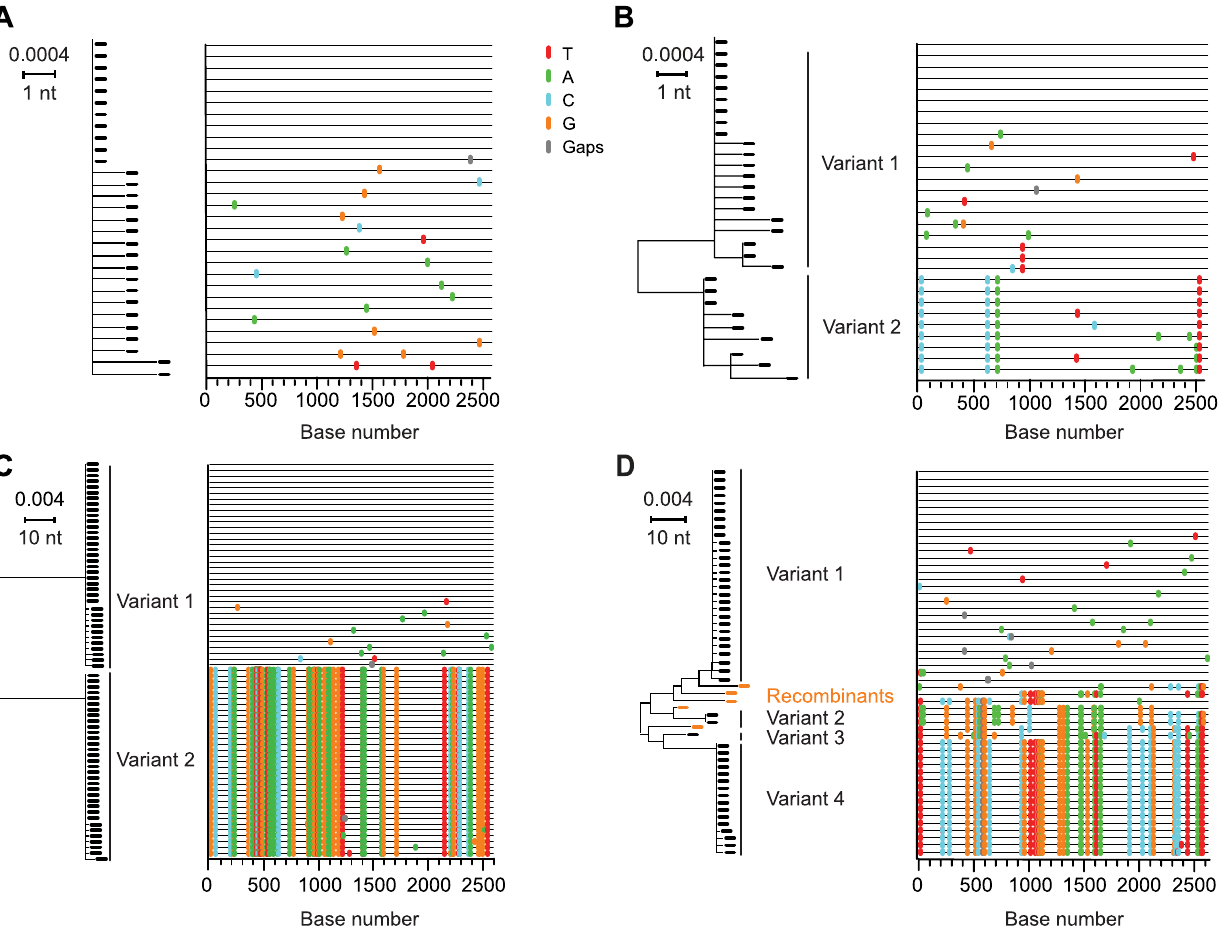
Figure 2. NJ trees and Highlighter plots of HIV-1 env diversity. Full-length gp160 env sequences from four subjects are depicted by NJ tree phylogenies and by Highlighter , a sequence visualization tool that allows tracing of common ancestry between sequences based on individual nucleotide polymorphisms [10]. Sequences from subject 04013440 ( A ) showed productive infection by a single virus, from subject 04013211 ( B ) infection by two closely related viruses, from subject 04013383 ( C ) infection by two distantly related viruses, and from subject 04013448 ( D ) infection by four viruses with inter-lineage recombinants denoted by orange symbols in the NJ tree. The horizontal scale bar represents genetic distance.